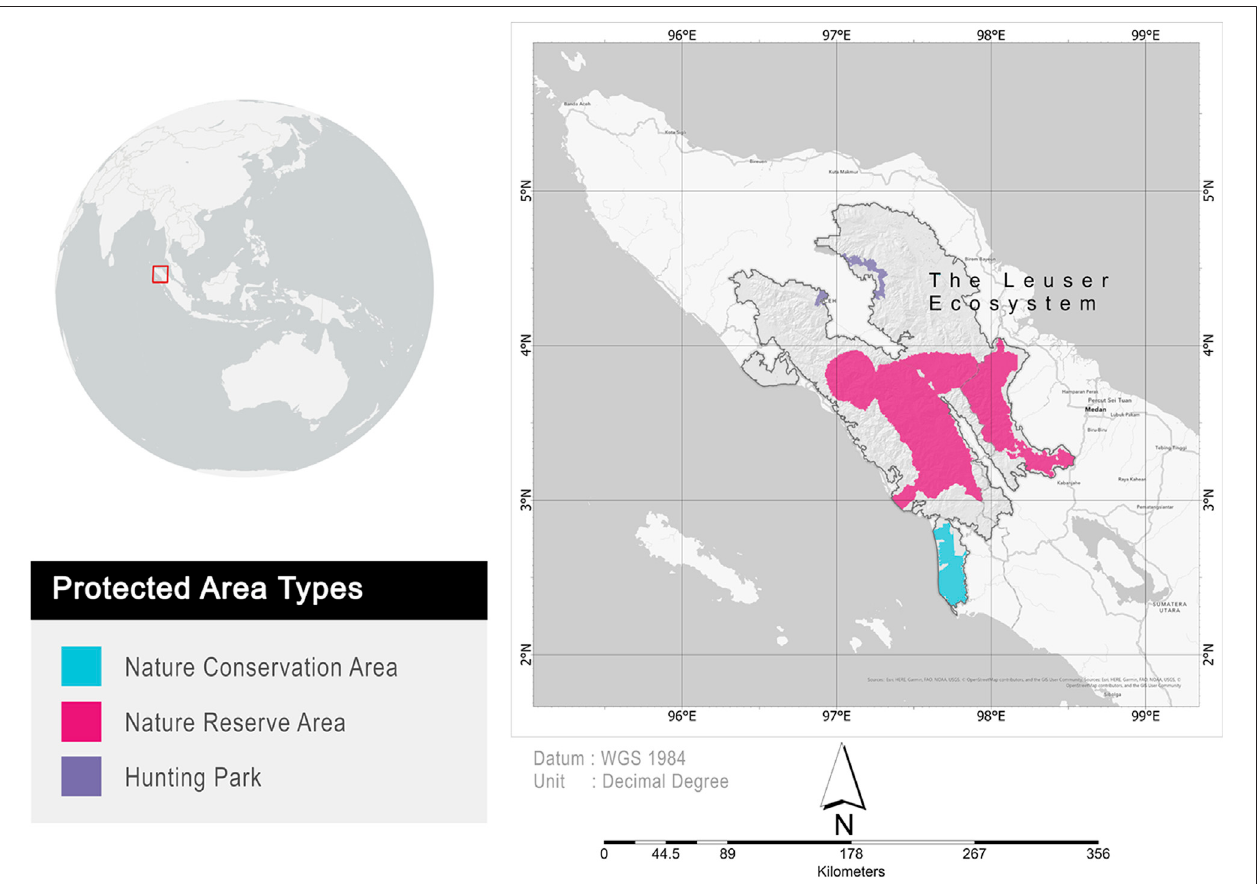
FIGURE 1 | Location of the Leuser Ecosystem and its protected areas. The conservation statuses of individual land management units were published by the Ministry of Environment and Forestry, Republic of Indonesia. Nature conservation area consists of national parks, nature recreation parks, and grand forest parks. Besides, the nature reserve area consists of strict nature reserve and wildlife